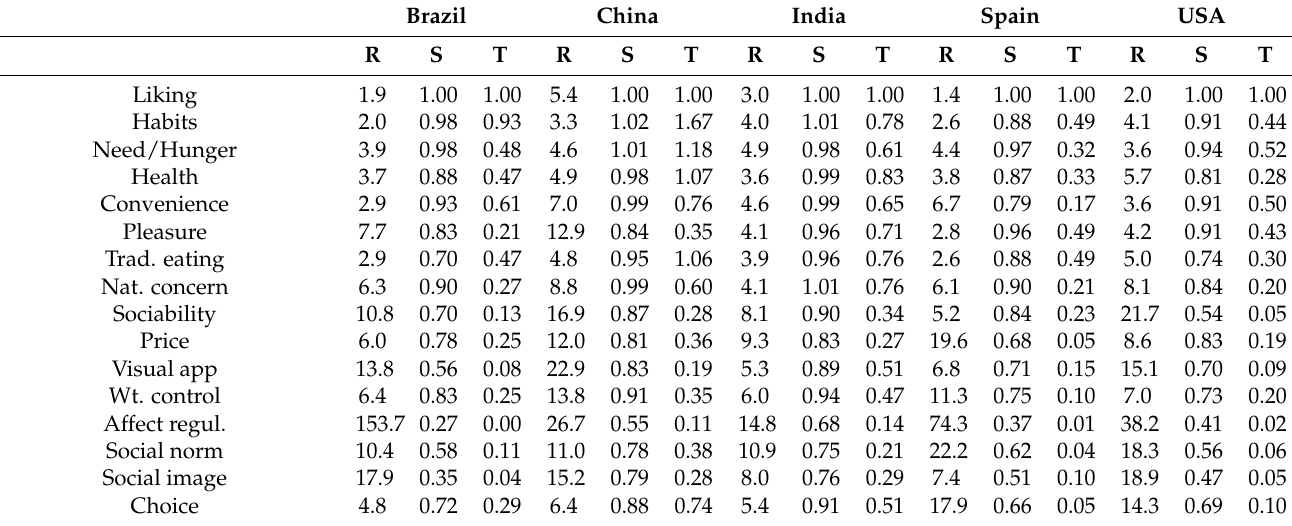
Table A6. Ratios of RATING “apply” responses to RATA “apply” responses (R) and standard indices of importance for RATING (S) and RATA (T) “apply” responses for each motivation construct to the liking motivation construct for starch-rich foods in all five